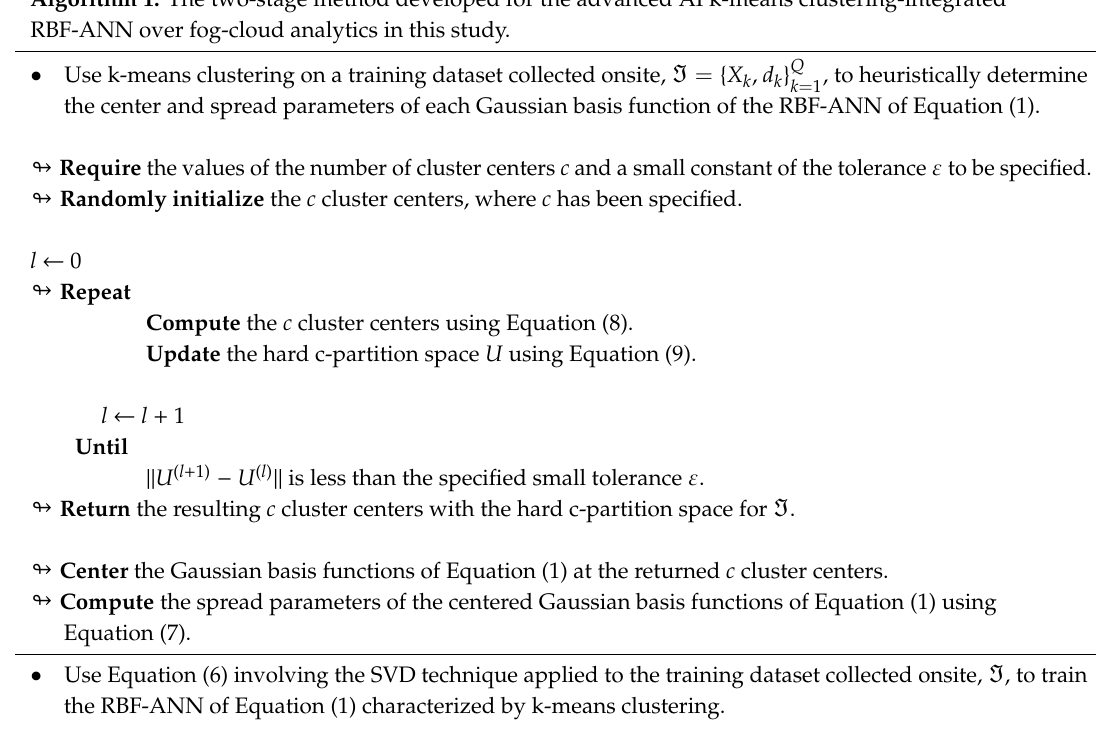
Figure 7. Proof-of-concept demonstration of the developed smart autonomous time and frequency analysis current sensor-based power meter prototype as edge analytics in the launched edge analytics-based AIoT architecture. ( a ) Sketch of the prototype designed, implemented, and installed for an electrical network topology and used as a smart electrical outlet for DSM in a smart grid. ( b ) Experimental setup of the prototype experimentally and practically evaluated (the prototype developed and experimentally tested in a laboratory environment in [23] is upgraded in this study).